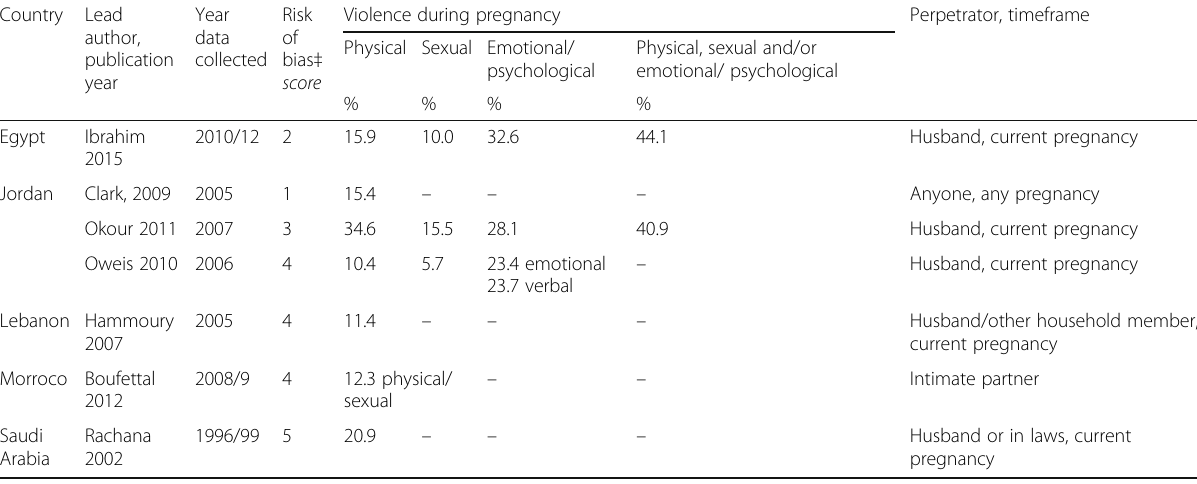
Table 7 Percentage of currently pregnant women reporting physical, sexual or emotional/psychological IPV during pregnancy Country Lead